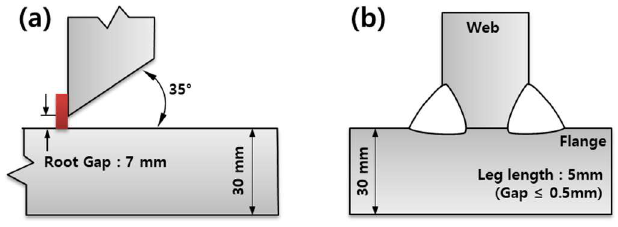
Figure 2. ( a ) Single beveled T-joint; ( b ) double-fillet T-joint.